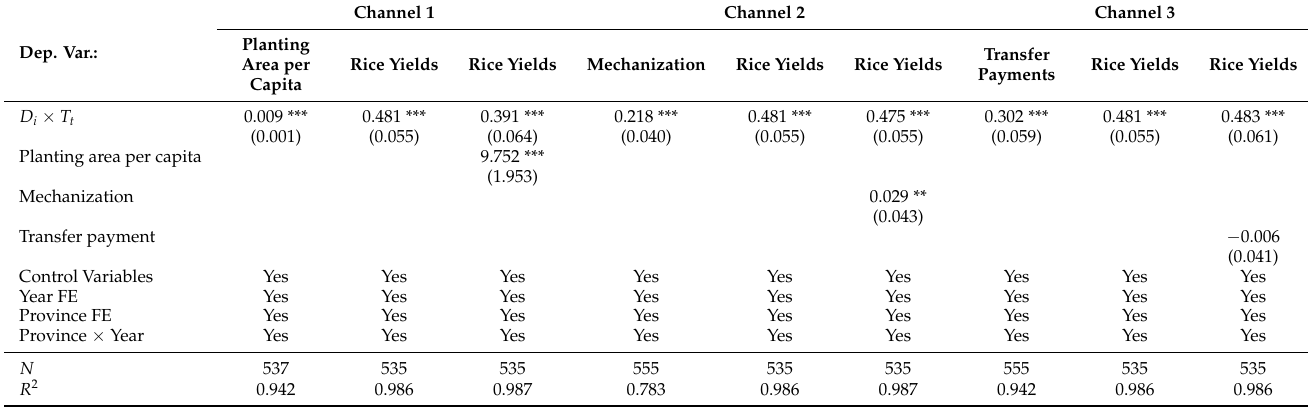
Figure A1. Synthetic control methods without placebo tests. Table A1. The channels of rice.